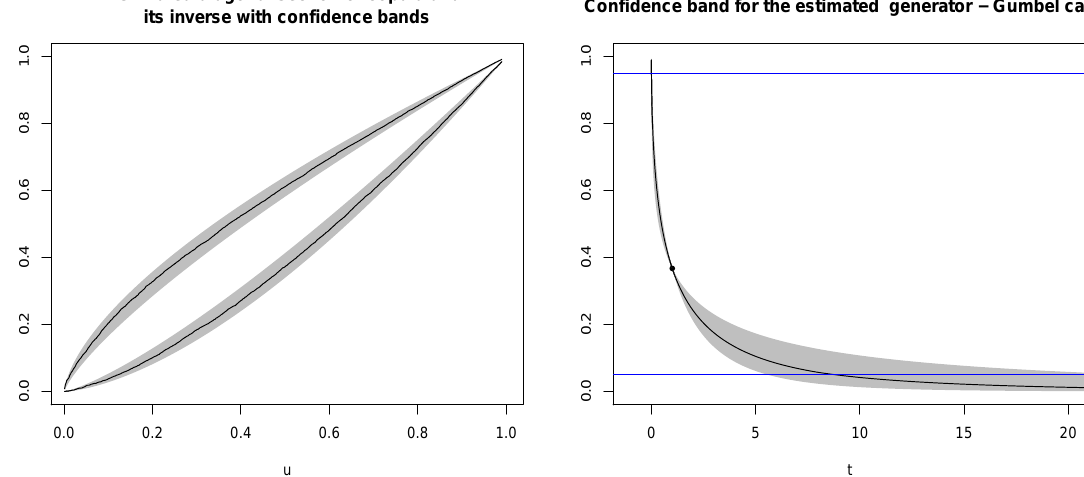
Figure 8. (Left) Confidence bands for b δ and b δ − 1 for chosen parameters α − = β − = 1 . 1 , α + = β + = 0 . 9 . (Right) Resulting confidence band for b φ . The considered copula is a Gumbel copula of parameter θ = 2 (i.e., Kendall’s τ = 0 . 5 ), the size of generated sample is n = 2000 . Horizontal blue lines are indicative chosen thresholds 0 . 05 and 0 . 95 of Figure 1 (see Remark